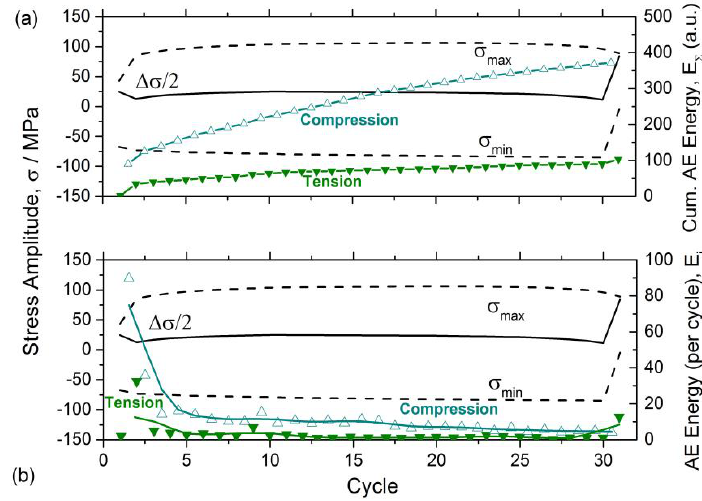
Figure 7. Trends in the twinning behavior assessed by the cluster analysis of AE time series in tension and compression during cyclic deformation of the Mg-4Zn-0.16Ca alloy tested at Δε t /2 = 1 × 10 −2 : ( a ) shows the cumulative AE energy and ( b ) the average AE energy per cycle.